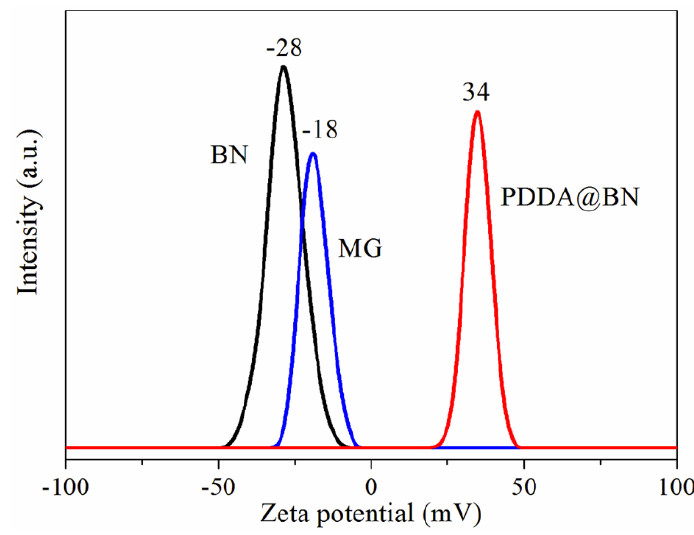
Figure 3. Zeta potential curves of BN, MG, and PDDA@BN.